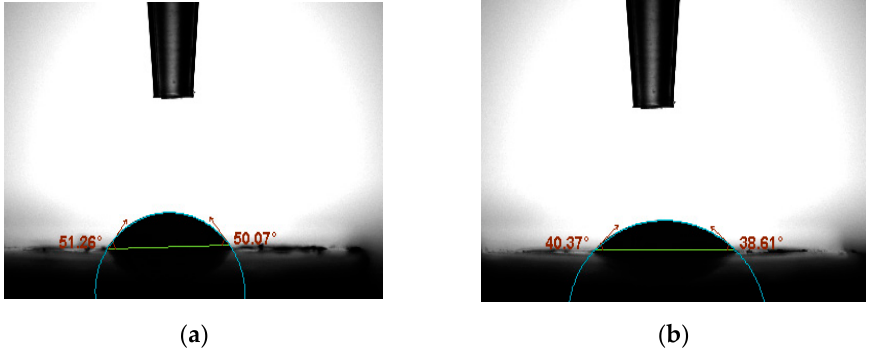
Figure 5. The contact angle test for ( a ) bare MWCNT/AuNPs and ( b ) targeted electrode PSA/MCH/aptamer/MWCNT/AuNP. R a = 13 nm. R a = 38 nm. R a = 25.2 nm